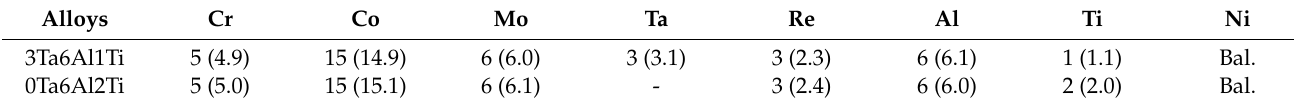
Table 1. The nominal and measured compositions (wt.%) of Ni-based SX superalloys. The measured compositions are listed in parentheses. The alloys are named by the concentration of Ta, Al, and Ti. For example, if the alloy contains 3 wt.% Ta, 6.4 wt.% Al, and 1 wt.% Ti, the alloy is called Table 1. Cont.